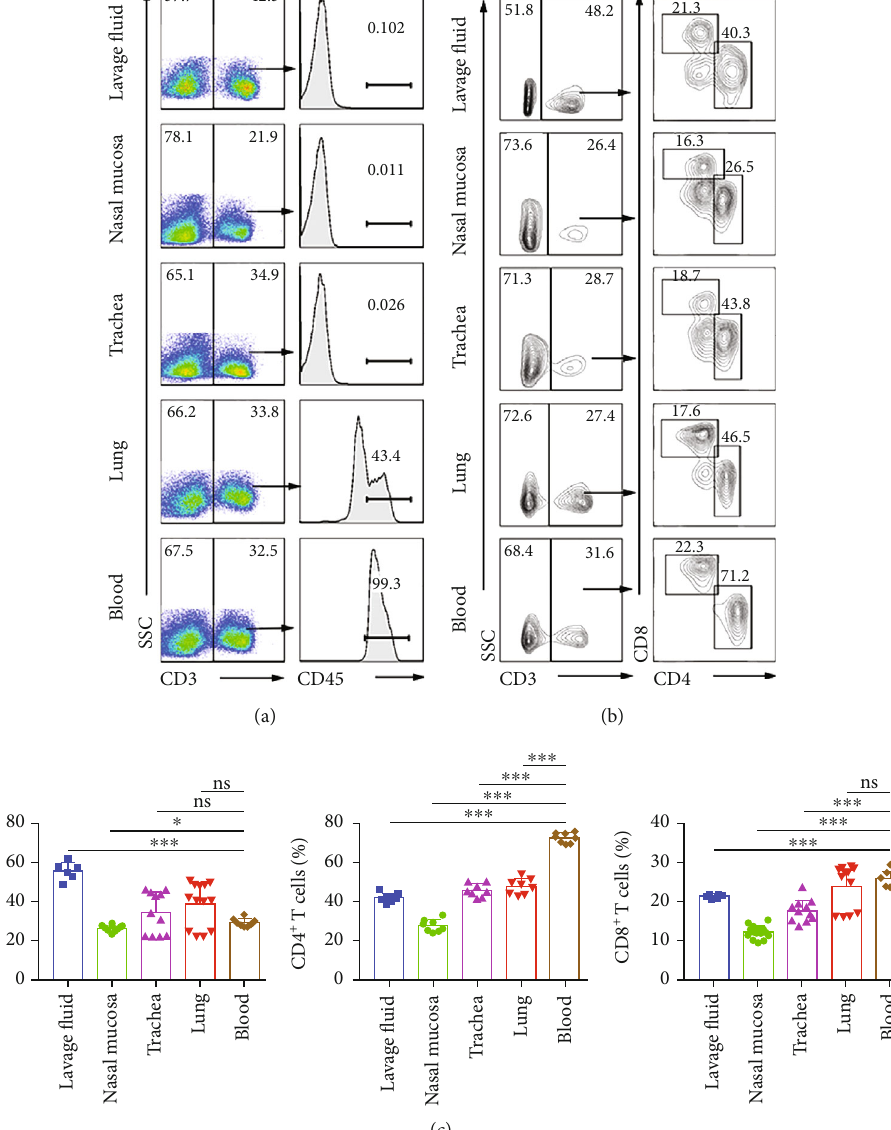
Figure 2: The proportions of CD3 + , CD4 + , and CD8 + T cells in the lavage fl uids, nasal mucosa, trachea, lungs, and blood. CD45 − CD3 + T cells (noncirculating T cells) and CD45 + CD3 + T cells (circulating T cells) from lavage fl uid, nasal mucosa, trachea, and lung tissues were distinguished by tail vein injection with fl uorochrome-conjugated CD45 antibody. (a) Live and singlet CD3 lymphocytes from nasal mucosa, trachea, lung tissues and blood were gated and subsequently analyzed on the percentage of labeled CD45 + T cells by fl ow cytometry. (b) Live and singlet CD45 − lymphocytes from lavage fl uid, nasal mucosa, trachea, and lung tissues and CD45 + lymphocytes from blood were gated and subsequently analyzed on CD3 + , CD4 + , and CD8 + T cells by fl ow cytometry. The tissue cells of the respiratory system were shown in the representative pseudocolor graphs. (c) The statistical results of noncirculating CD3 + , CD4 + , and CD8 + T cells in lavage fl uids, nasal mucosa, trachea, and lungs and circulating CD3 + , CD4 + , and CD8 + T cells in blood were shown as mean ± SEM of eight independent experiments. Statistical signi fi cance was determined with one-way ANOVA for multiple comparisons. ∗ P < 0 : 05 and ∗∗∗ P < 0 : 001 ; ns: no signi fi